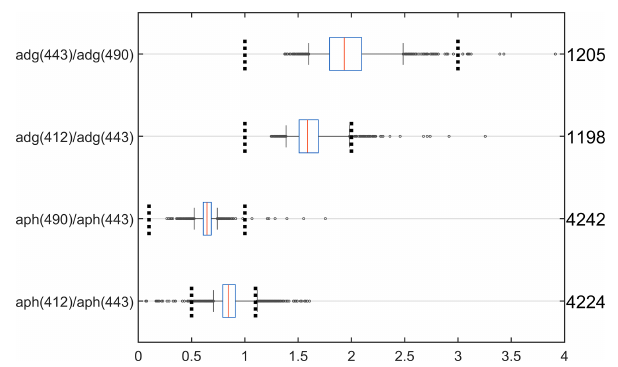
Figure 13. The distribution of absorption coefficients band ratios: adg(443) / adg(490), adg(412) / adg(443), aph(490) / aph(443) and aph(412) / aph(443). Data within 2nm of the wavelengths were used. The graphical convention is identical to Fig. 2. The vertical dashed lines show the lower and upper thresholds used for qual- ity control in the IOCCG report 5. The total number of points for “adg” ratios are divided between NOMAD (89%), COAST- COLOUR (7%), MERMAID (3%), and Seabass (1%). The to- tal number of points for “aph” ratios are divided between NO- MAD (28%), TPSS (23%), AWI (23%), COASTCOLOUR (14%), SeaBASS (10%), and MERMAID